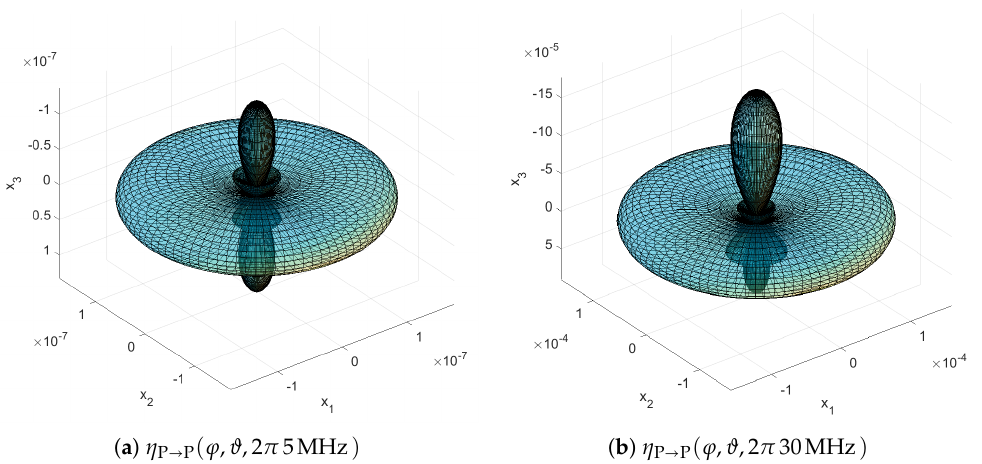
( ϕ , ϑ ,2 π f ) (in mm − 3 ) for a single scatterer size P (cid:1)